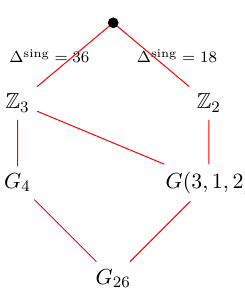
Figure 4 . Hasse diagram for the moduli space of the N = 3 theory obtained from the type- e 7 (2,0)